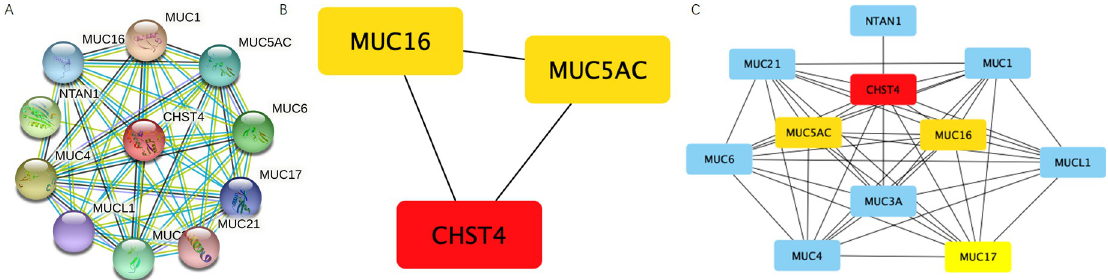
Fig 5. PPI networks of CHST4. (A) all genes in PPI networks, (B) hub genes in PPI networks, (C) hub genes and other genes in PPI